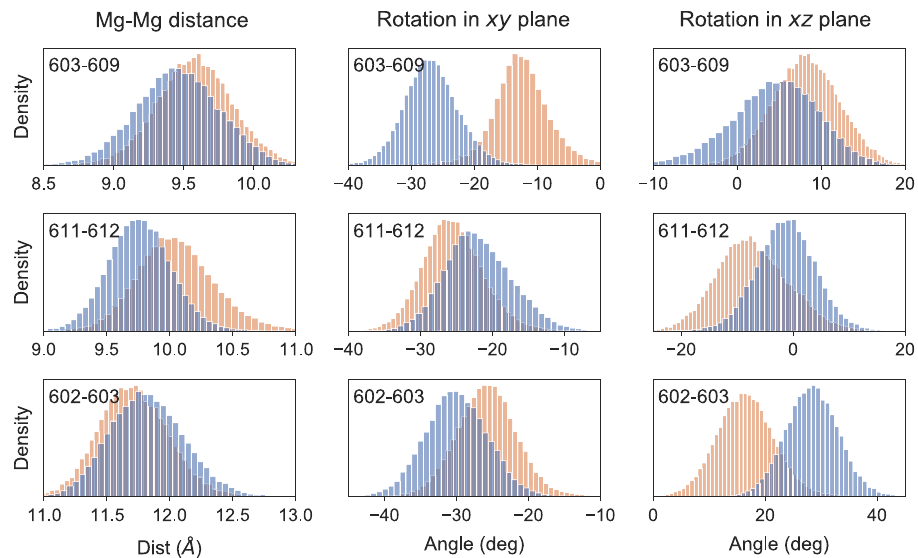
Fig. 3 Comparison of mutual distances and orientations for the chlorophyll strongest coupled pairs in LHCSR1. LHCSR1 Cluster 4 is shown in orange and CP29 is shown in blue. The fi rst column corresponds to the Mg – Mg distance between chlorophylls, the second column to the mutual rotation of the chlorophylls in the plane de fi ned by the chlorophyll ring, and the last column corresponds to a rotation in the plane perpendicular to the chlorophyll ring. The analysis was performed on 40,000 con fi gurations extracted every 50 ps of the MD simulation for LHCSR1 and on 30,000 con fi gurations with the same time-step for